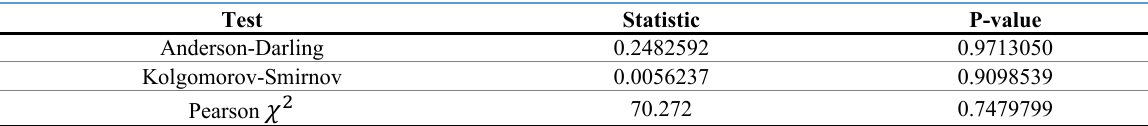
Table 2. Goodness-of-fit tests for